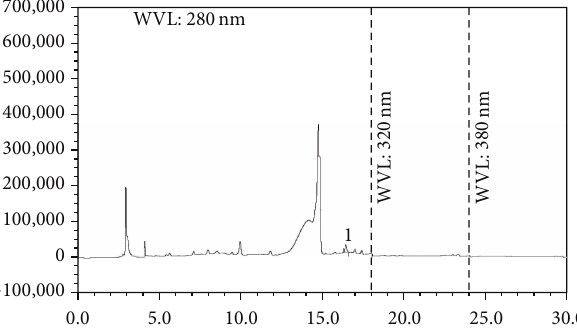
Figure 5: HPLC chromatogram of Z. budrunga seed extract (1: caffeic